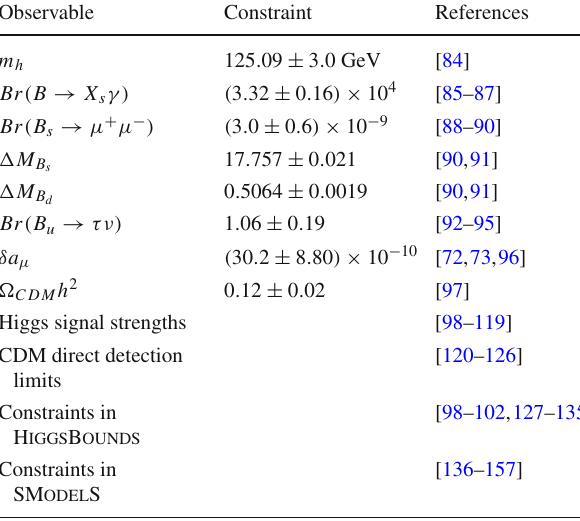
Table 4 Summary of the data used for the pNMSSM global fits. Theo- retical uncertainties have been added in quadrature to the experimental colddarkmatterdirectdetectionlimitsimplementedareshowninFig.4. Finally, the HiggsBounds and SmodelS constraints impose the 95% C.L. bounds on collider pseudo-observables such as σ. Br for